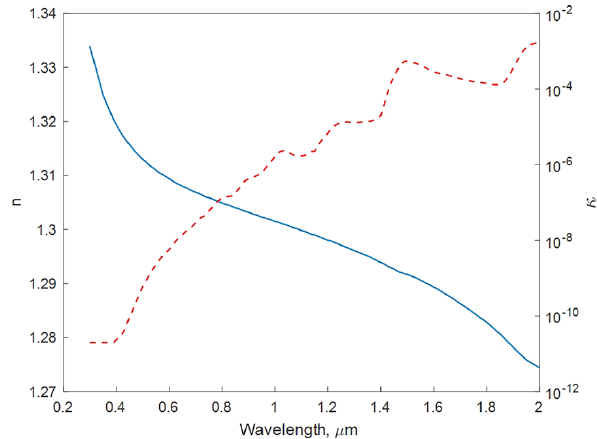
Figure 2. The refractive index of ice after Warren and Brand (2008): real part (left axis, solid curve) and imaginary part (right axis, dashed